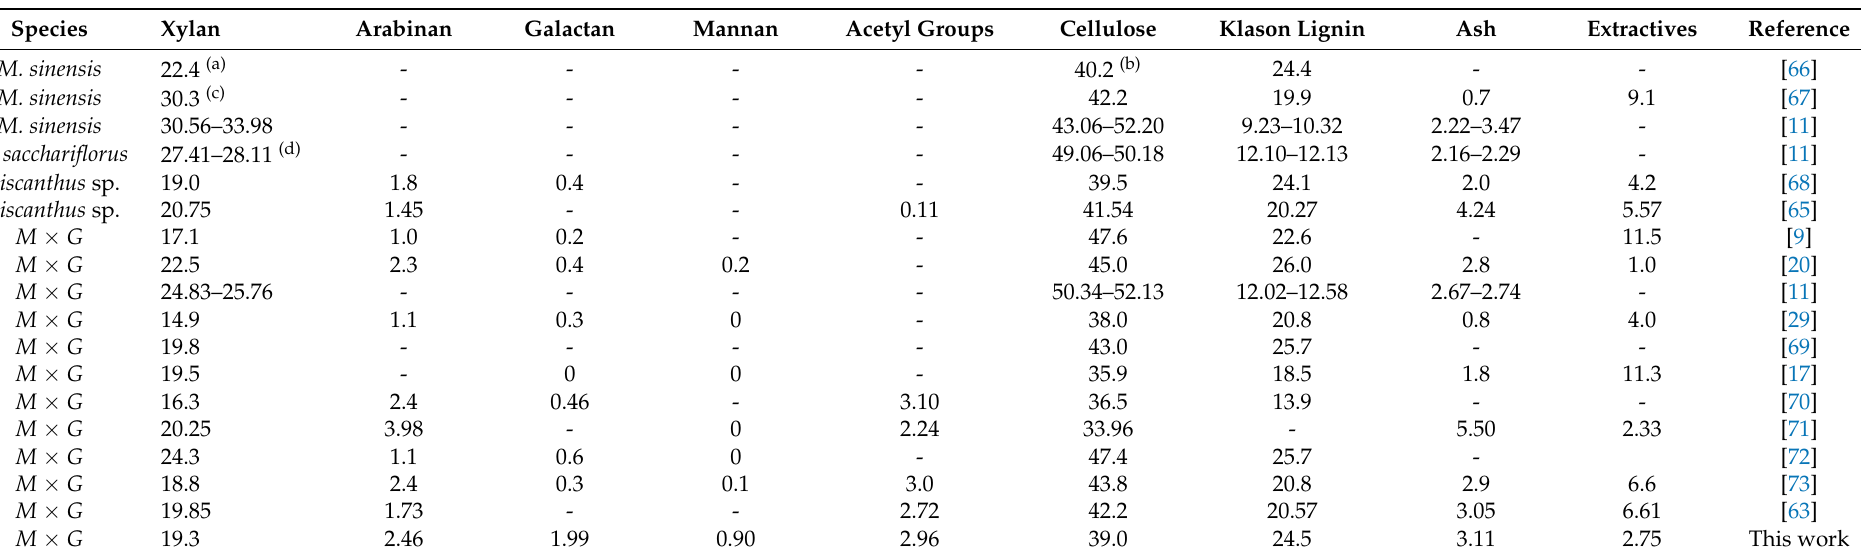
Table 2. Compositional results reported for Miscanthus and the experimental results achieved in this study. Data are expressed as wt% on an oven-dried